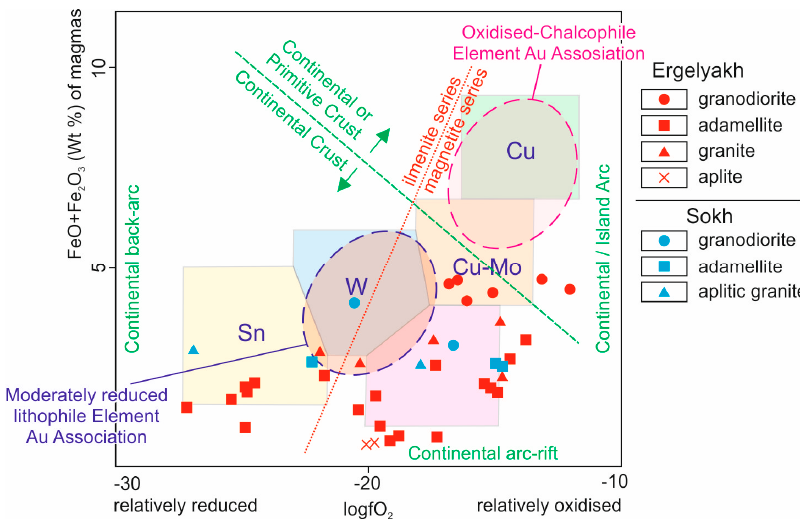
(Figure 12), data points for the EIRGD granitoids fall into fields of di ff erent mineralization types (Cu–Mo, Mo, W, Sn, and, partly, moderately reduced lithophile element Au association).